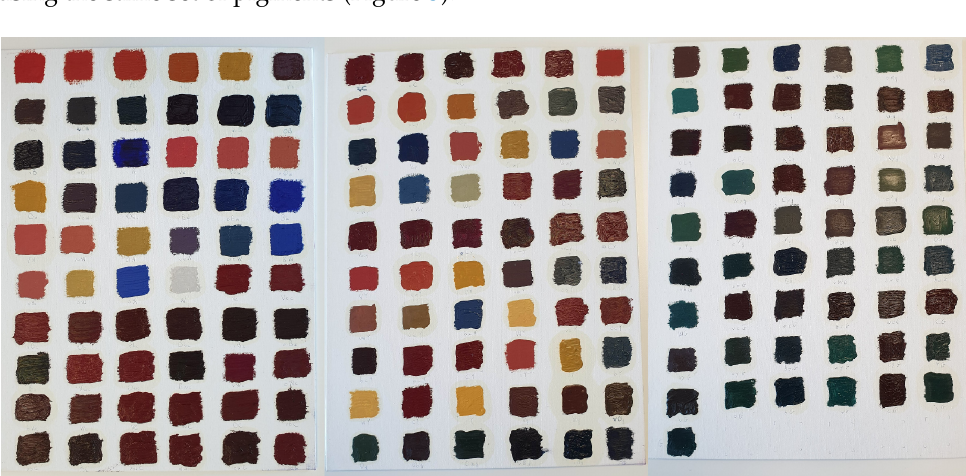
Figure 2. Set of mockup samples realised for the experiment. The 175 painted patches are ordered according to a script, not considering perceptual similarities. Reproduced from [29] with permission from the International Colour Association (AIC).